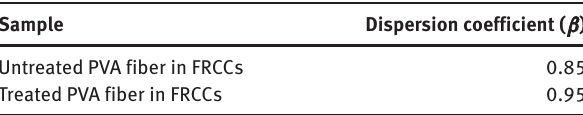
Table 1: Dispersion coefficient of PVA fibers in cement